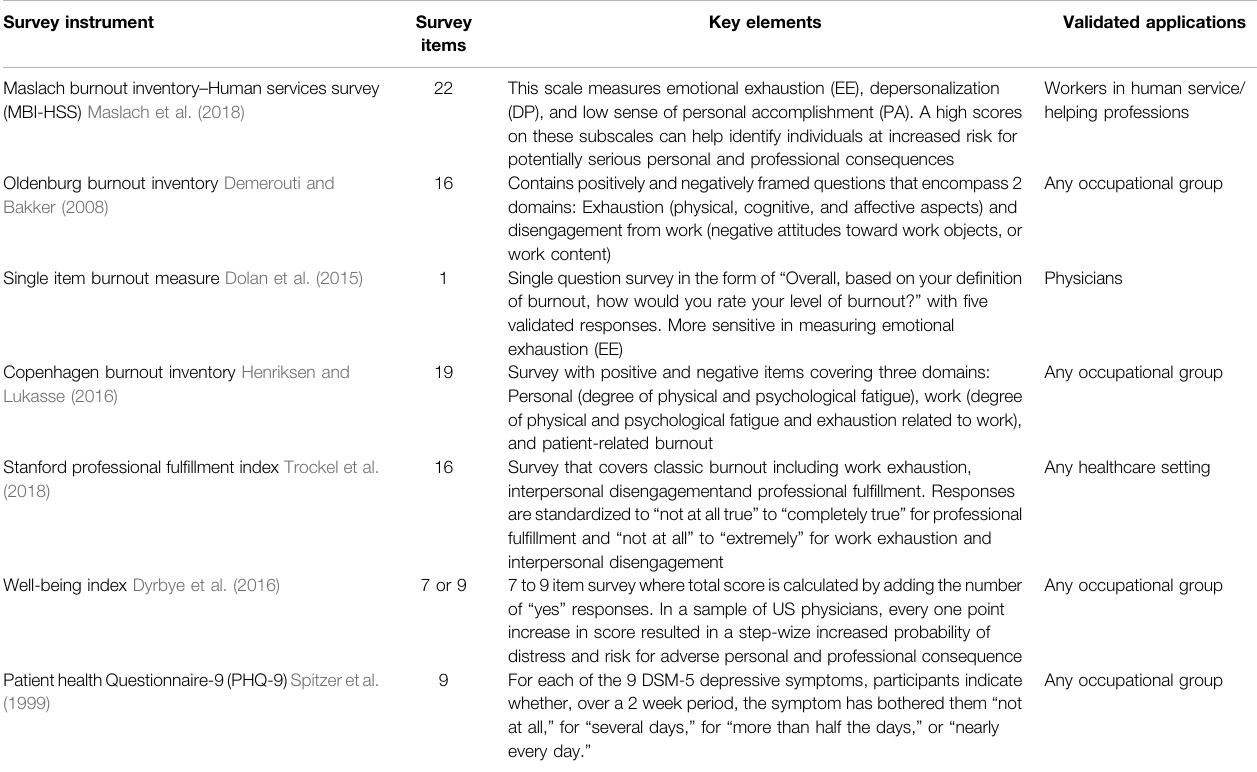
TABLE 1 | Validated survey instruments for measuring